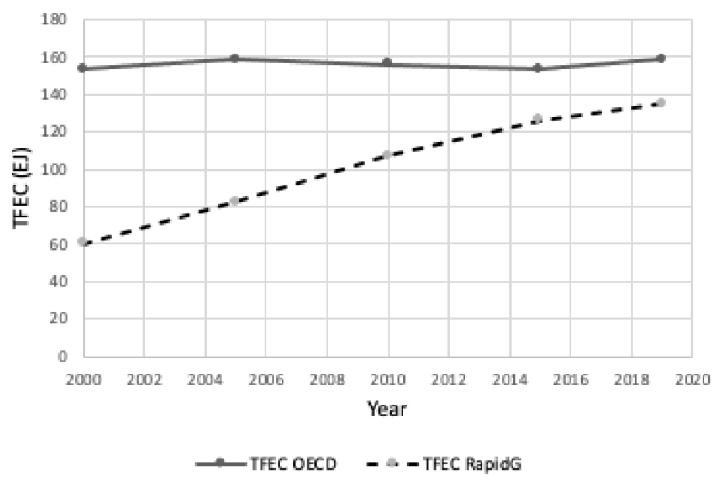
Figure 2. TFEC growth in the total OECD and total RapidG economies, 2000–2019.